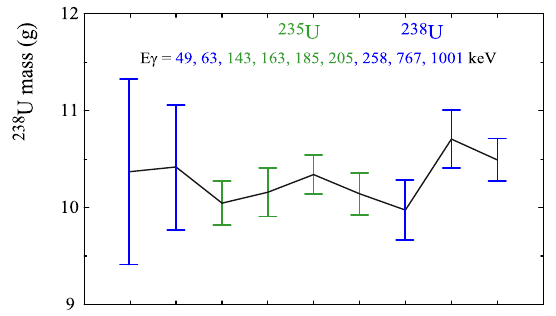
Fig. 3. Calculated 238 U mass as a function of the analysed g -peaks from radioactivity of